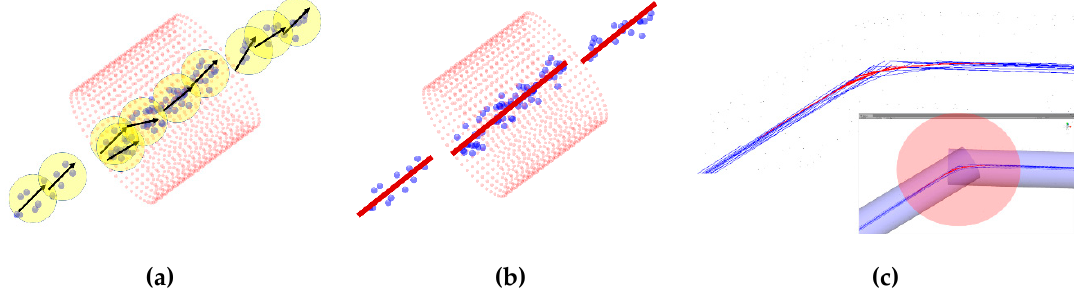
Figure 7. Search method for center axis estimation: ( a ) eigenvector at a point; ( b ) sum of eigenvectors; ( c ) matching cylinder result through vector summation.